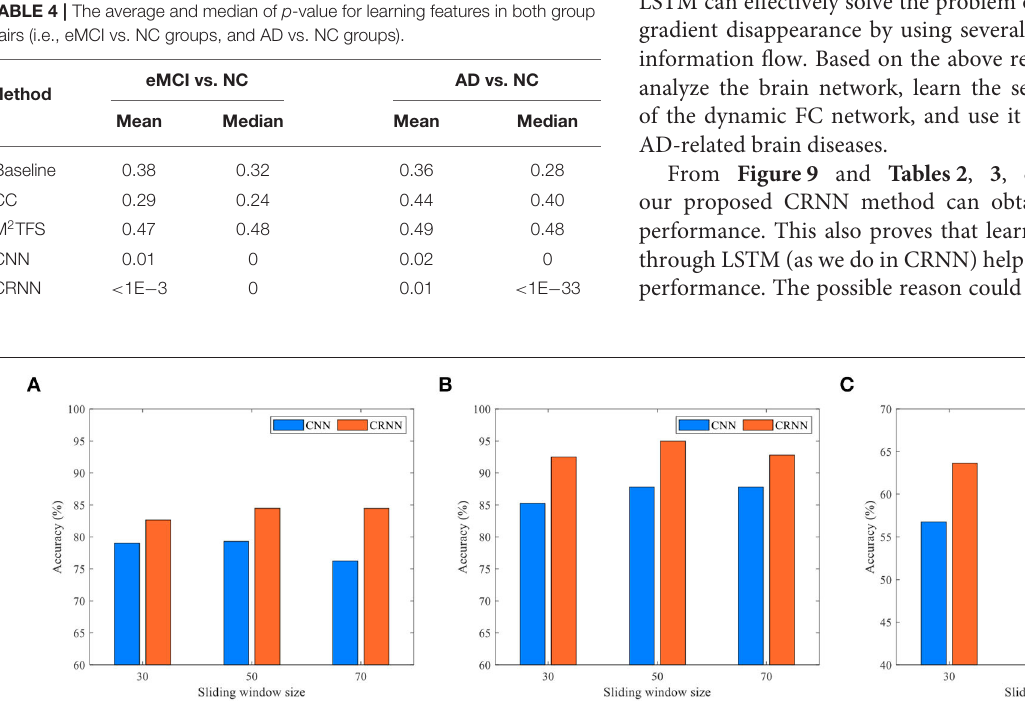
FIGURE 9 | Classification accuracy of the CRNN and CNN methods using different lengths of sliding windows in three tasks: (A) eMCI vs. NC classification, (B) AD vs. NC classification, and (C) AD vs. lMCI vs. eMCI vs. NC classification.